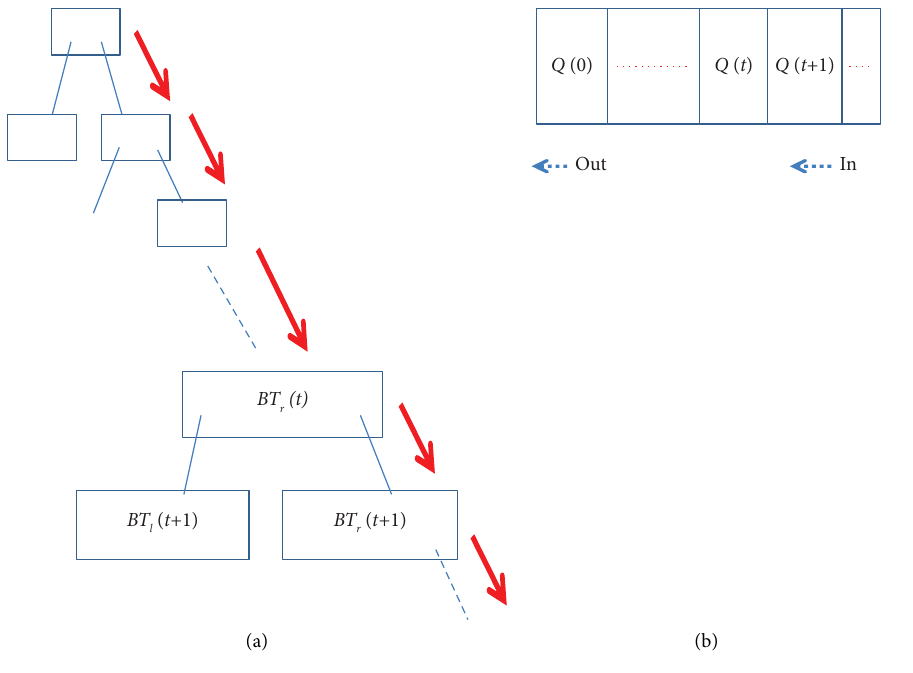
Figure 3: Updating binary tree and